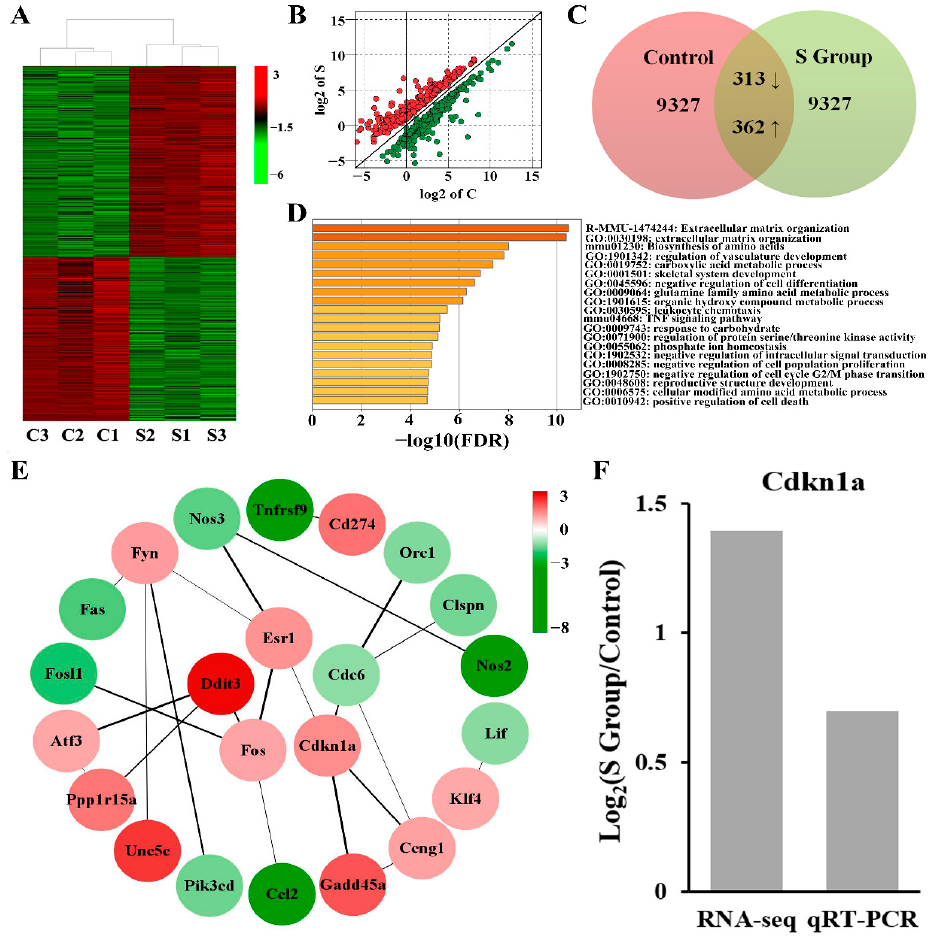
Figure 6. The Tubb4b deletion affects gene expression on mouse spermatogonia. ( A ): The clustered heatmaps of DEGs between mouse spermatogonia in the control and experimental groups. The letter C means the control group, while the letter S means the experimental group, same below. And red indicates high relative expression, and green indicates low relative expression. ( B ): The scatter plot of the DEGs. Red dots represent up-regulated genes expressions, and green dots represent downregulated genes expressions. Data were log2(FC) transformed. ( C ): Venn diagram of the DEGs. ( D ): The Bar plots of enrichment analysis for the DEGs in different modules. The length of the bars indicates significance ( − log10 transformed Benjamini–Hochberg adjusted FDR) and the enrichment moduli of the DEGs are shown on the right. ( E ): Network of DEGs associated with cell proliferation and cell cycle of mouse spermatogonia from three major GO. The target proteins are contained in the circle while the colour signifies the fold change of the DEGs. Furthermore, the number at the top right represents log2(FC) and the line is the strength of the protein interaction. ( F ): The expression analysis of P21 between RNA-Seq and RT-qPCR in mouse spermatogonia. Cdkn1a also means the gene of P21